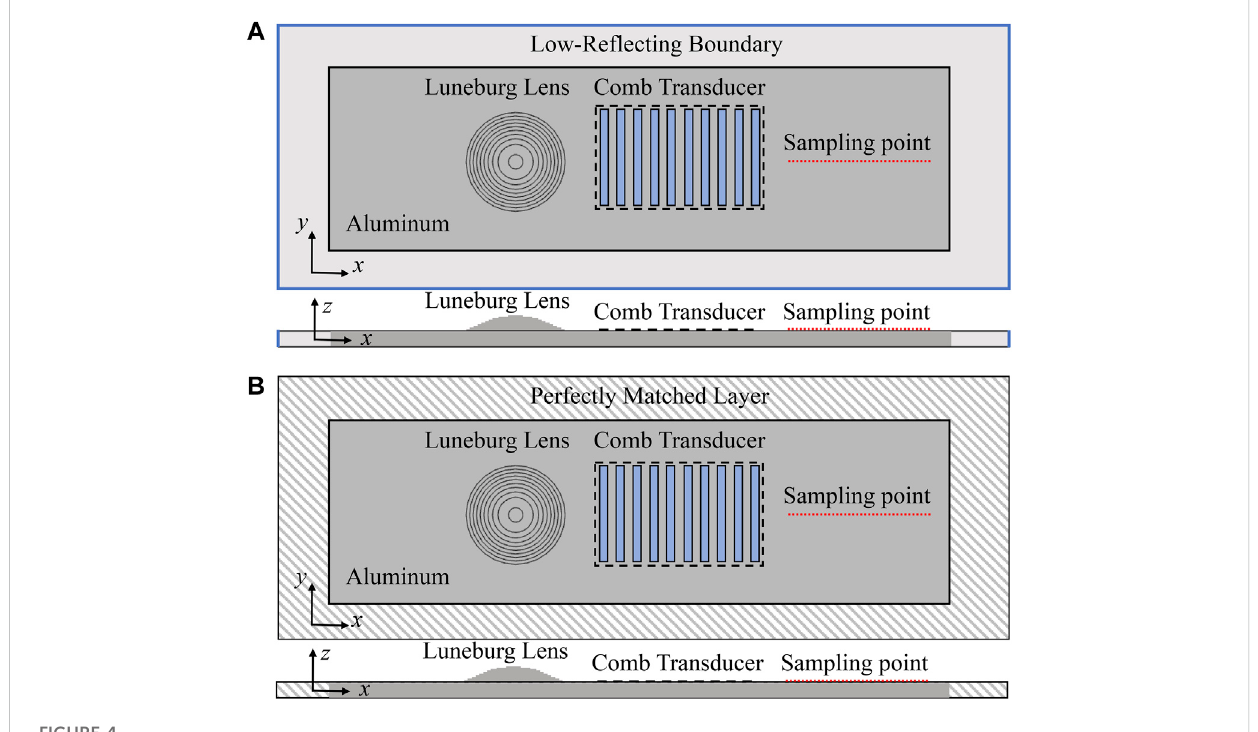
FIGURE 4 Schematic of the FEM model in a top view and side view: (A) the time domain analysis, (B) the frequency domain